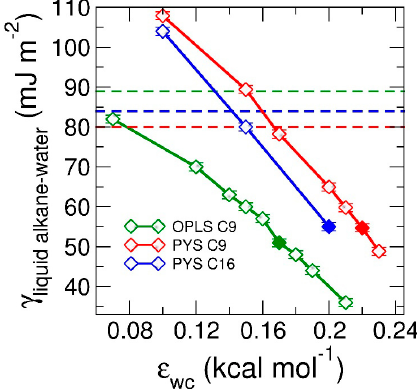
Figure 3. Surface tension of liquid alkane–water interface, γ lw , as a function of the coupling between water and alkanes, ε wc . Green, red, blue curves correspond to surface tensions of OPLS nonane (C9), PYS nonane (C9) and PYS hexadecane (C16), respectively. The surface tensions are computed at the same temperatures as in the experimental references: 295 K for nonane [87] and 313.15 K for hexadecane [97]. Solid squares represent the ε wc at which experimental surface tension are reproduced. Note that in the limit where the water–alkane interactions become purely repulsive, the surface tension of the water–alkane interface can be larger than the sum of the surface tensions of non–interacting water–vacuum and alkane–vacuum interfaces. The latter is given by the sum of the surface tension of the water–vacuum interface (66 mJ·m − 2 at 295 K [105]) and the liquid alkane–vacuum interfaces (Tables 1 and 2), γ wv + γ lv , and are shown with dashed lines.